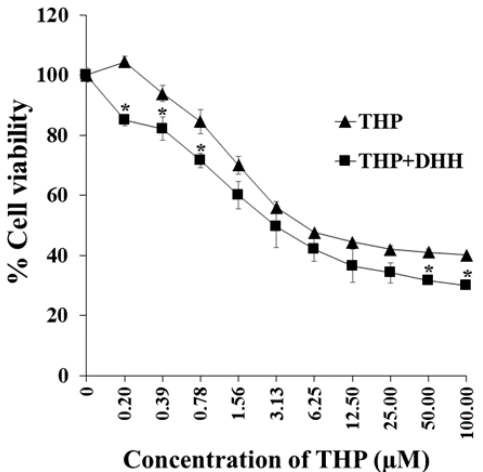
Figure 9. Effect of DHH on the cytotoxicity of THP. K562/ADR cells (1.0 × 10 4 cells/well) were cul-